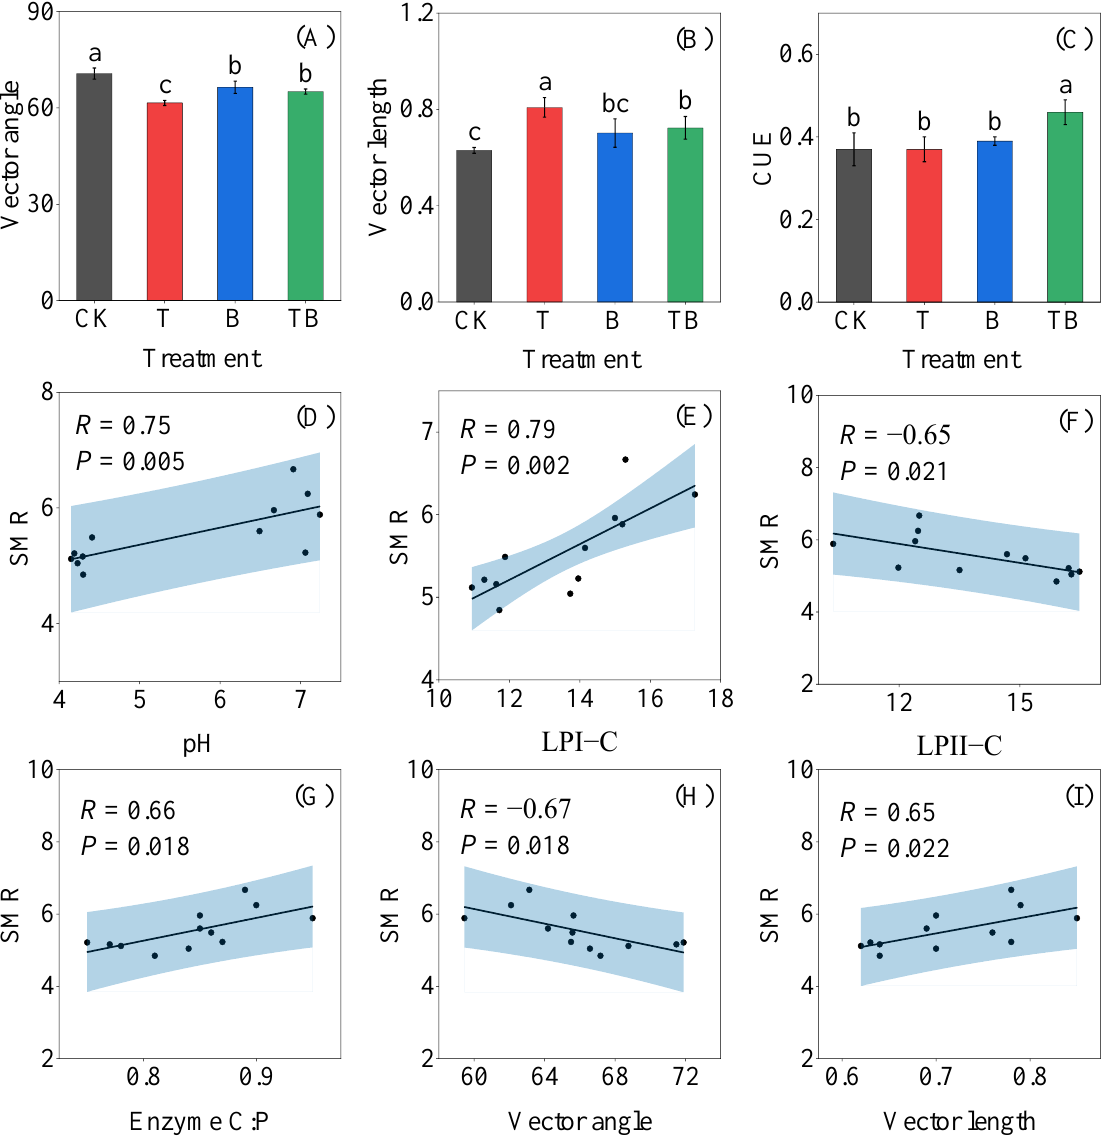
Figure 4. A comparison of vector angle ( A ), vector length ( B ) and microbial carbon use efficiency (CUE) ( C ) (mean ± SE) among the different treatments, including the control (CK), oyster shell powder (T), biochar (B) and a combined amendment (TB), and correlation analysis of soil microbial respiration rate (SMR) with pH, LPI − C, LPII − C, enzyme C:P ratio, vector angle and vector length ( D – I ). Bars with different letters indicate significant differences ( p < 0.05).